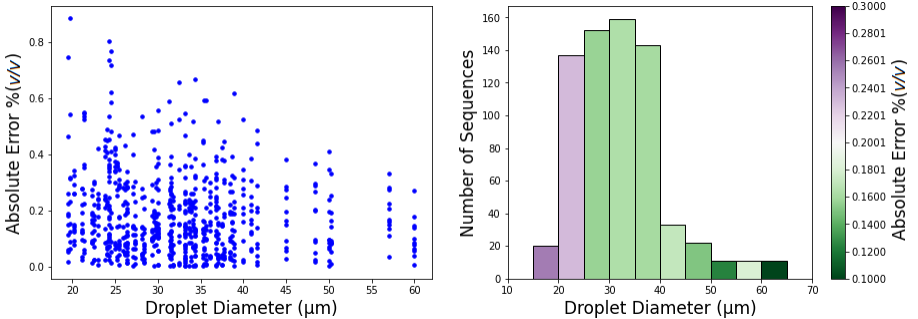
Figure 12. CNN3D test set MAE as a function of droplets diameters. ( Left ) individual droplet prediction error; ( Right ) MAE by droplet